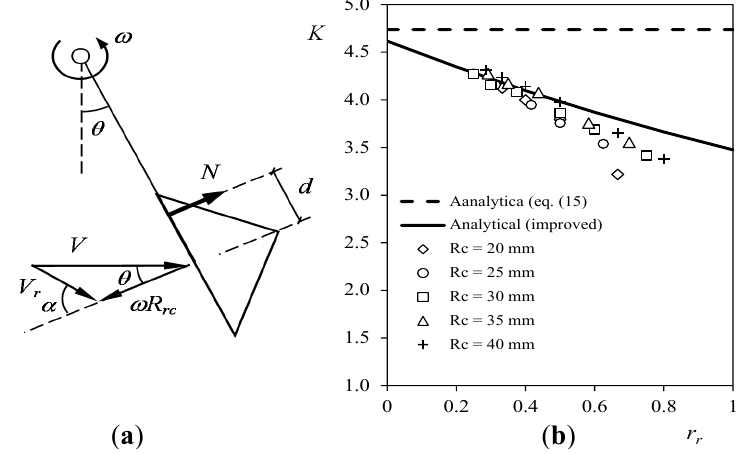
Figure 11. ( a ) Sketch of the variables involved in the rotation movement of an anemometer’s cup. See that the normal aerodynamic force, N , is considered to be deviated from the center of the cup. ( b ) Anemometer factors, K , measured from anemometers equipped with different rotors (varying the cups’ radius, R c , and the cups center rotation radius, R rc ), in relation to the geometric ratio r r = R c / R rc . In the graph, the results from the analytical model developed (Equation (15)) and its improved version (Equations (17) and (18)) are included.